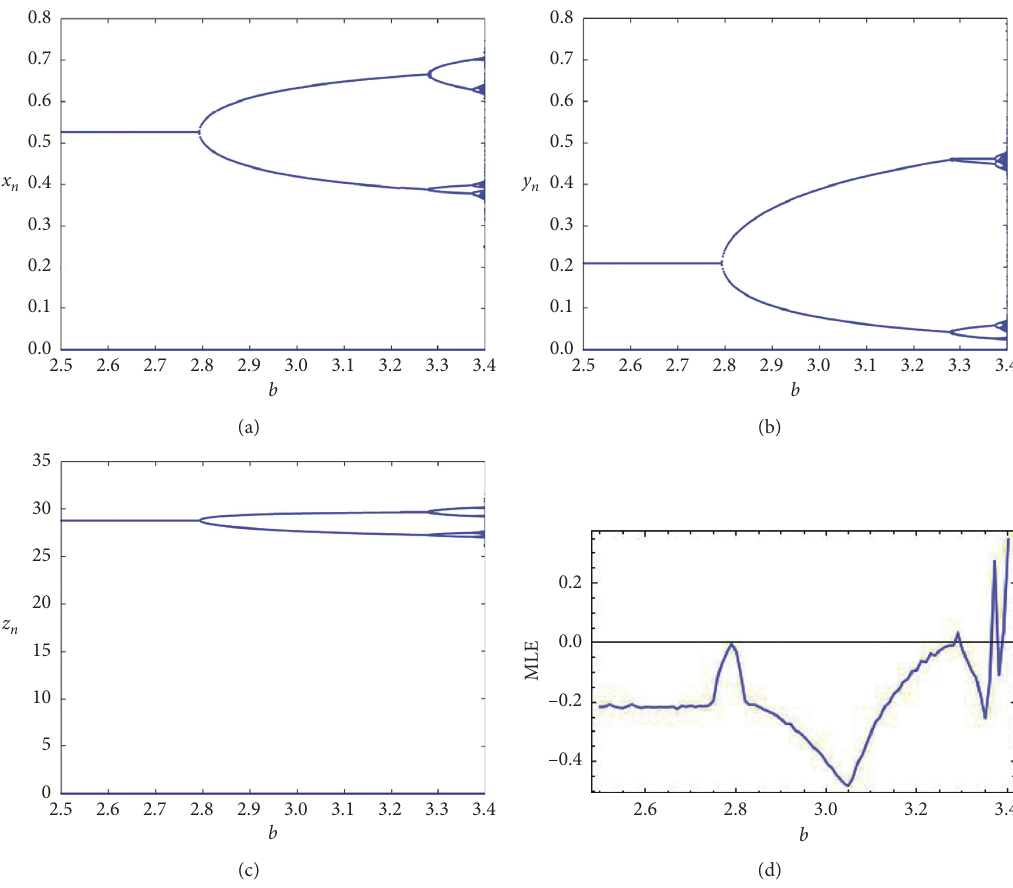
Figure 4: Bifurcation diagrams and MLE for system (2) with r � 4 . 8, k � 1 . 5, α � 2 . 5, β � 1 . 7, a � 0 . 1, c � 0 . 4, d � 0 . 1, δ � 3 . 2, m � 3 . 5, η � 1 . 6, b ∈ [ 2 . 5 , 3 . 4 ] , and initial conditions ( x (c) Bifurcation diagram for z n . (d) Maximum Lyapunov exponents.